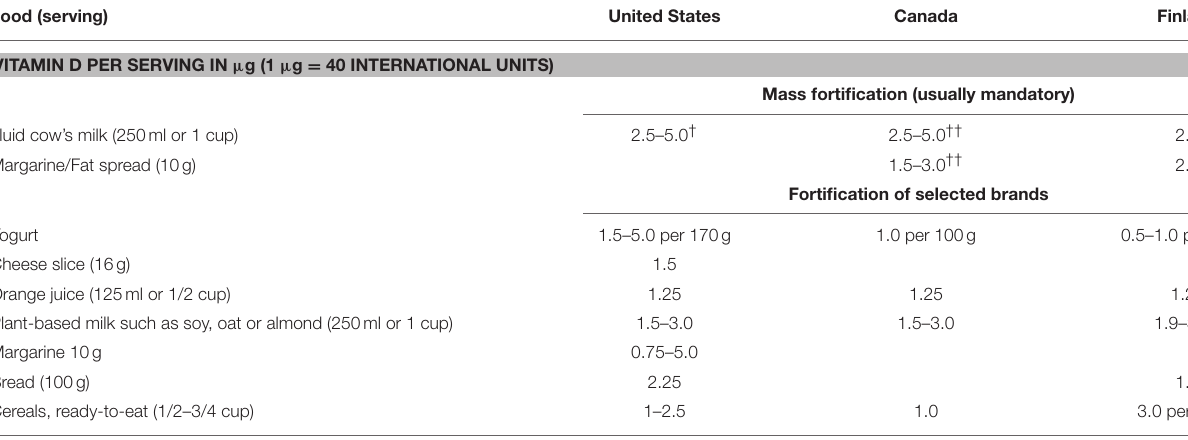
TABLE 3 | Vitamin D food fortification in the United States, Canada and Finland. Food